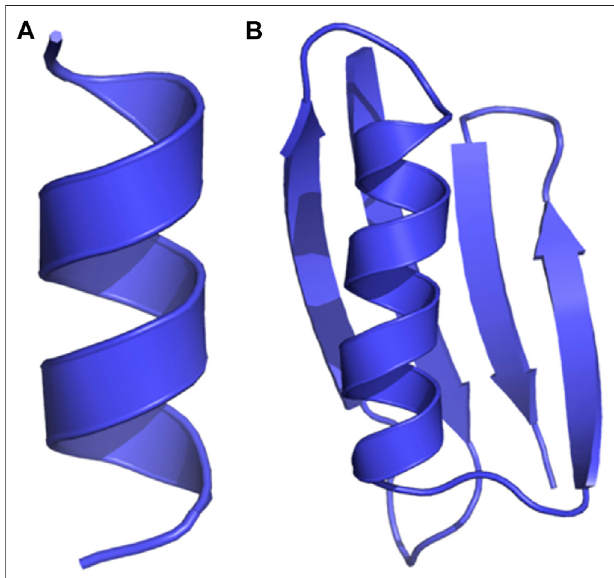
FIGURE 4 | Initial structures of the proteins studied. (A) A 12 is a dodecapeptide with 12 alanine residues, and (B) GB98 is a small protein with four beta-sheets and one alpha